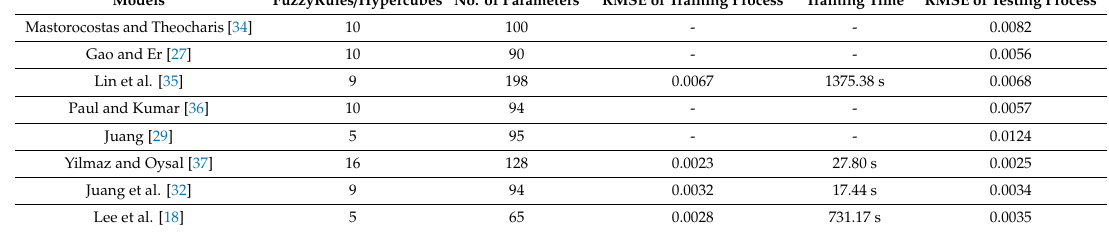
Table 3. A comparison of di ff erent predictors for chaotic time series prediction. Models